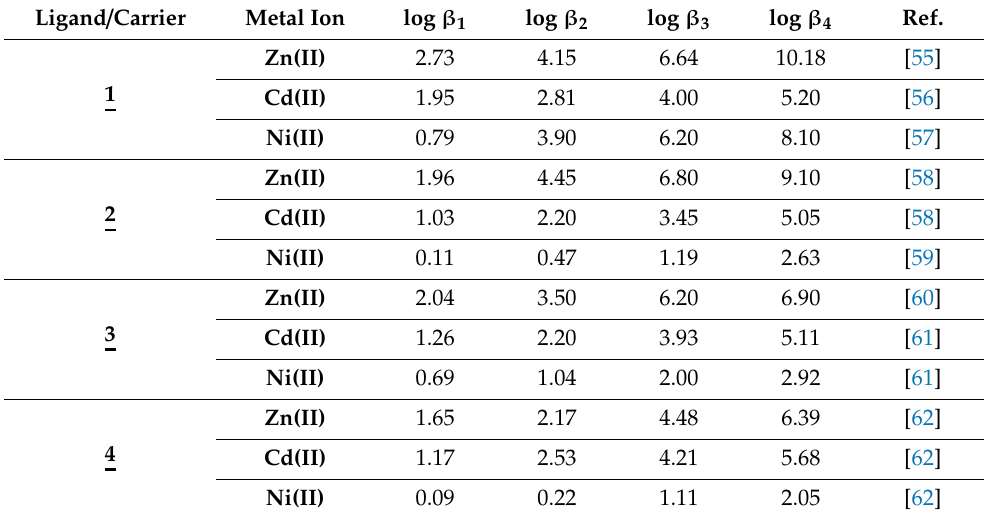
Table 3. Comparison of the stability constants β n of Zn(II), Cd(II), and Ni(II) complexes